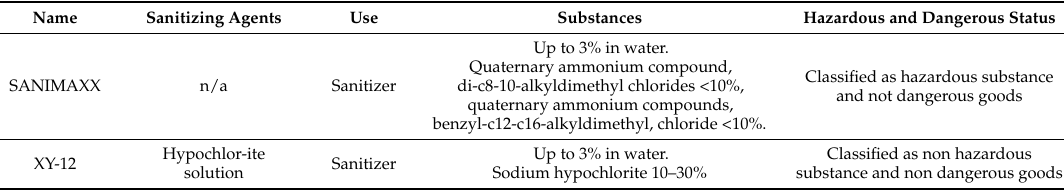
Table 6. Specification and status of chemicals in use at an Australian